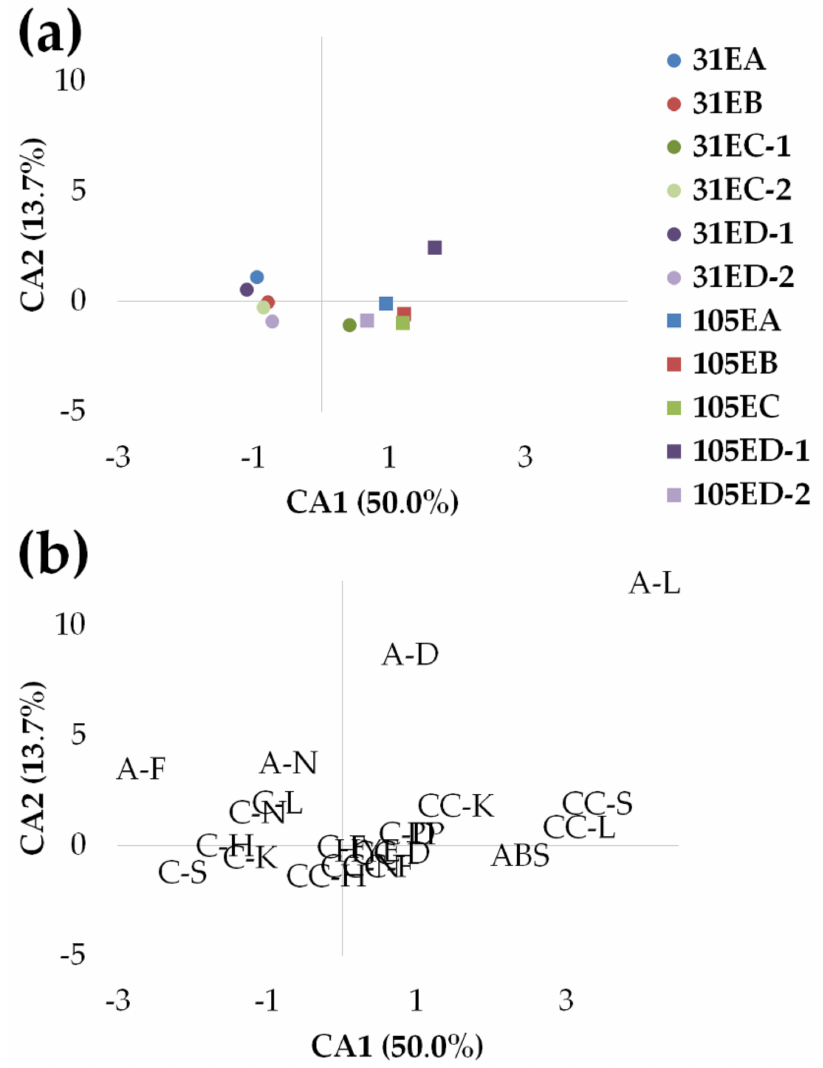
Figure 4. Correspondence analysis results on the frequency matrix (FM) at 31 and 105 days after hatching: ordination model of diet-tank groups (31 EA, 31 EB, 31 EC-1, 31 EC-2, 31 ED-1, 31 ED-2, 105 EA, 105 EB, 105 EC, 105 ED-1, 105 ED-2) ( a ) and descriptor points ( b ) in axis 1 and axis 2. Note the overlapping anomaly categories CC-F, CC-D, CC-N, and HYE (b). A-D: abdominal (A)